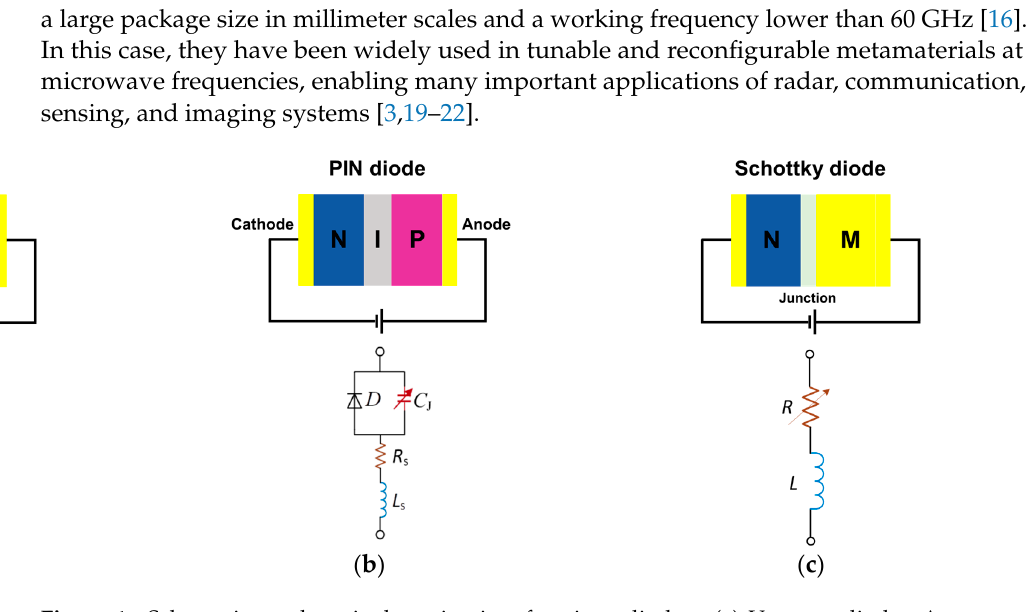
Figure 1. Schematics and equivalent circuits of various diodes. ( a ) Varactor diode. As a p − n diode under reverse bias, its equivalent circuit is a voltage − controlled capacitor. ( b ) PIN diode. Its equivalent circuit model is a tunable resistor. ( c ) Schottky diode. Its equivalent circuit model is a voltage − controlled resistor.